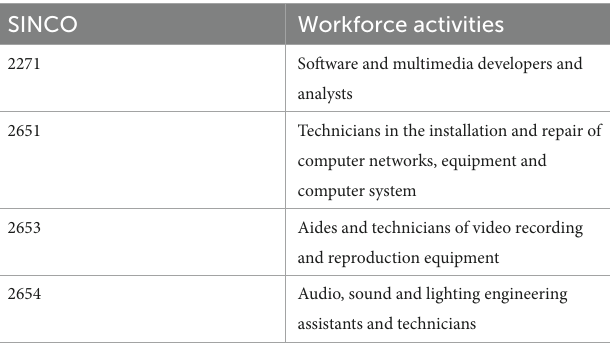
TABLE 1 SINCO codes and workforce activities for NAICS branches. SINCO